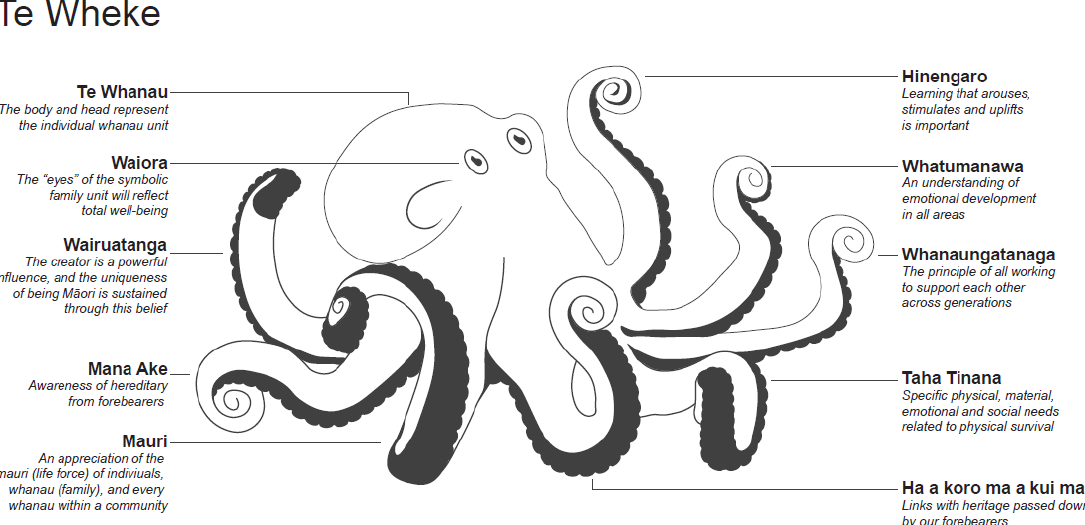
Figure 2. Te Wheke. Source: Redrawn from Pere RT. 1997. Te Wheke: A Celebration of Infinite Wisdom. NZ: Ao Ako Global Learning.